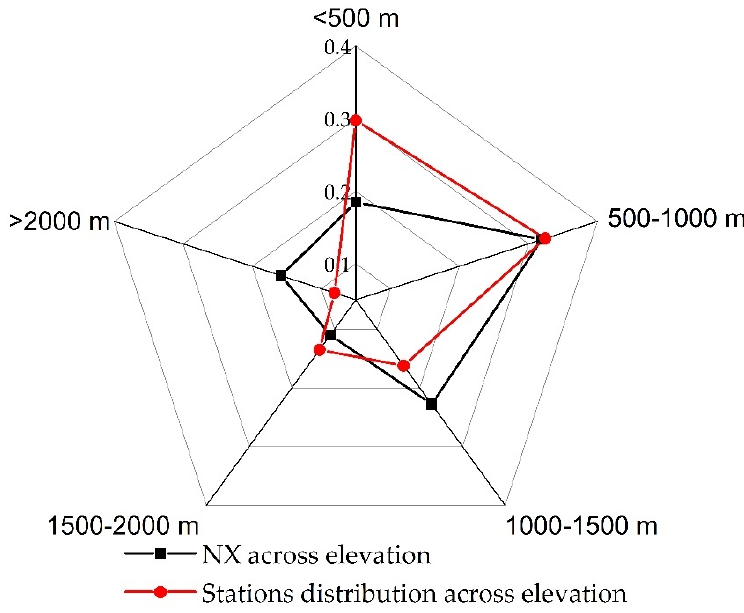
Figure 13. Comparison between stations distribution and NX across elevation. Table 6. Stations distribution and NX across aspect.